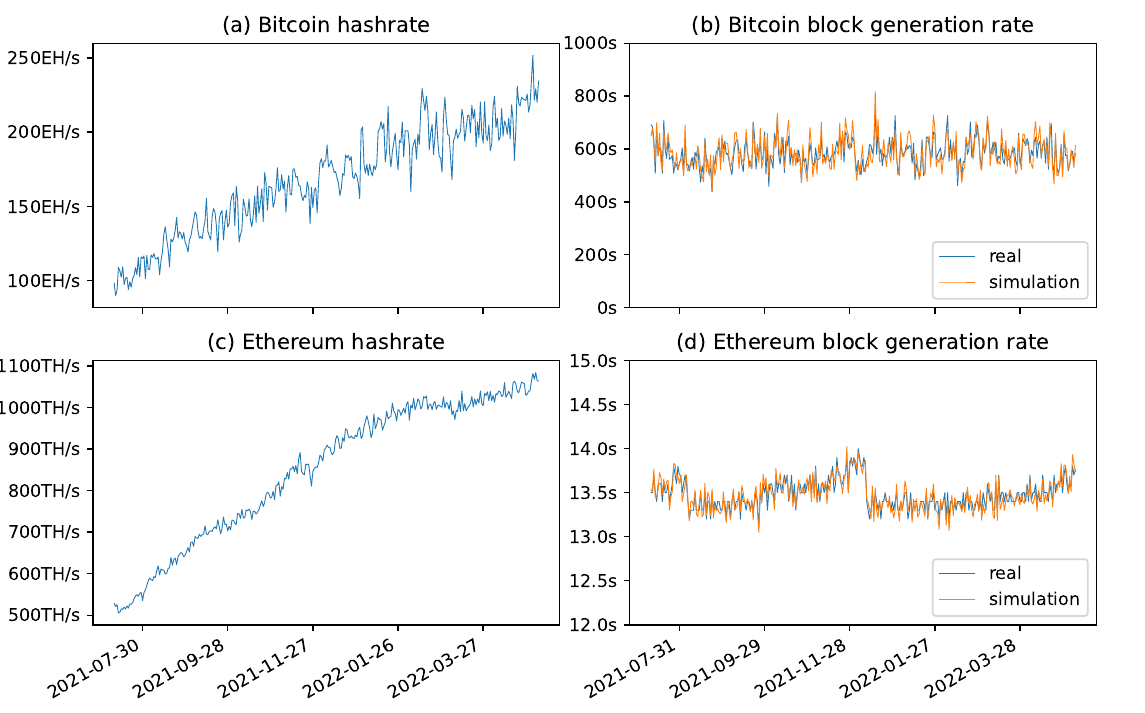
Figure 6. Comparison of the block generation